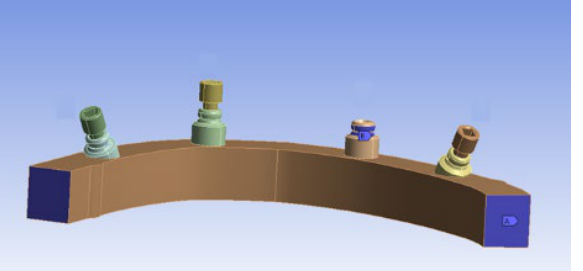
Figure 2. The simplified mandible model with implants and OT-Equator inserted and only 3 prosthetic screws.